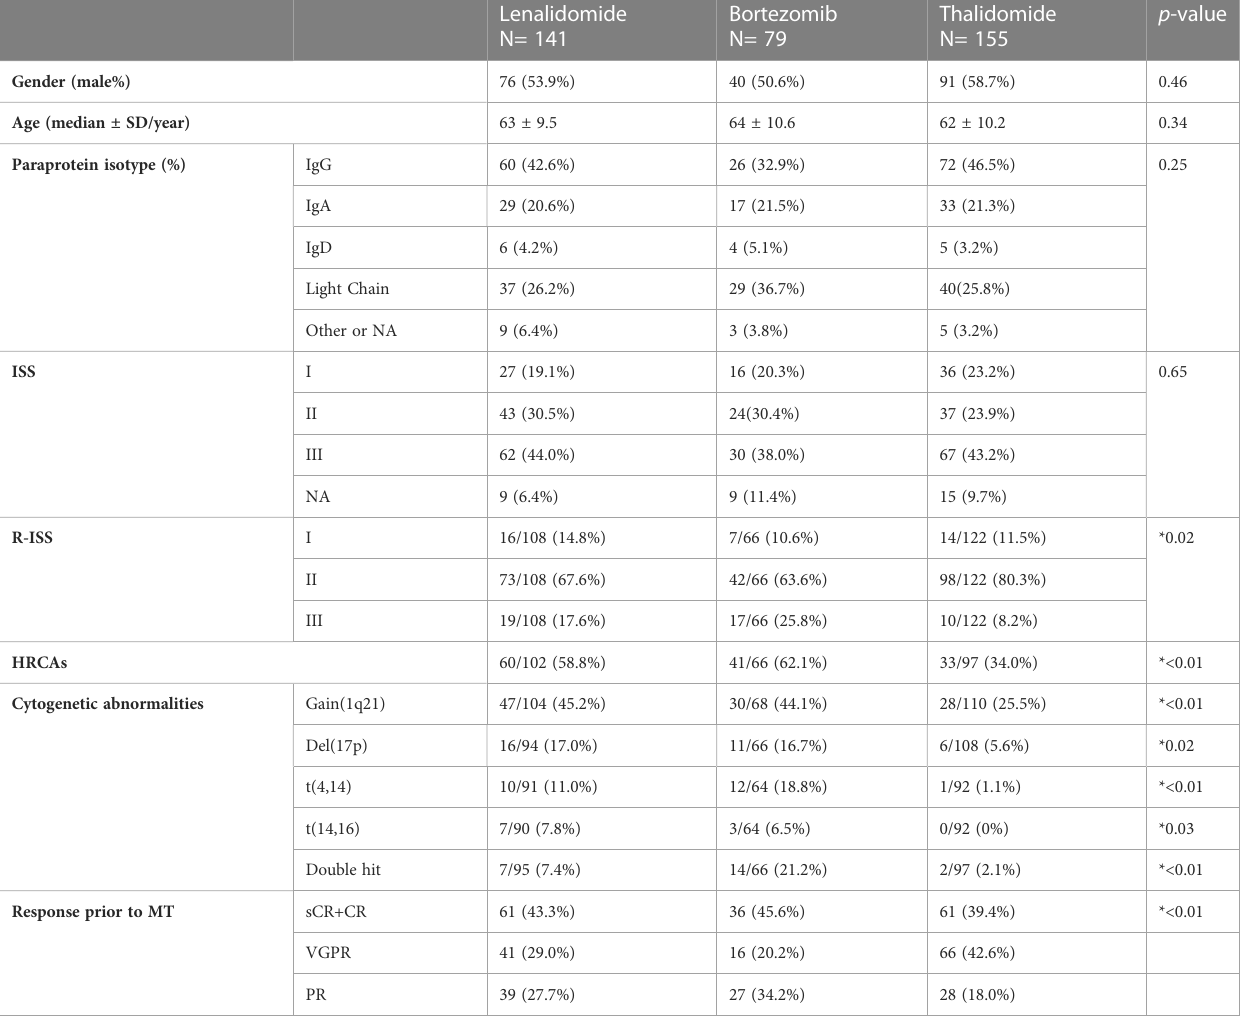
TABLE 1 Baseline demographic characteristics in non-transplant NDMM patients with lenalidomide, bortezomib, or thalidomide